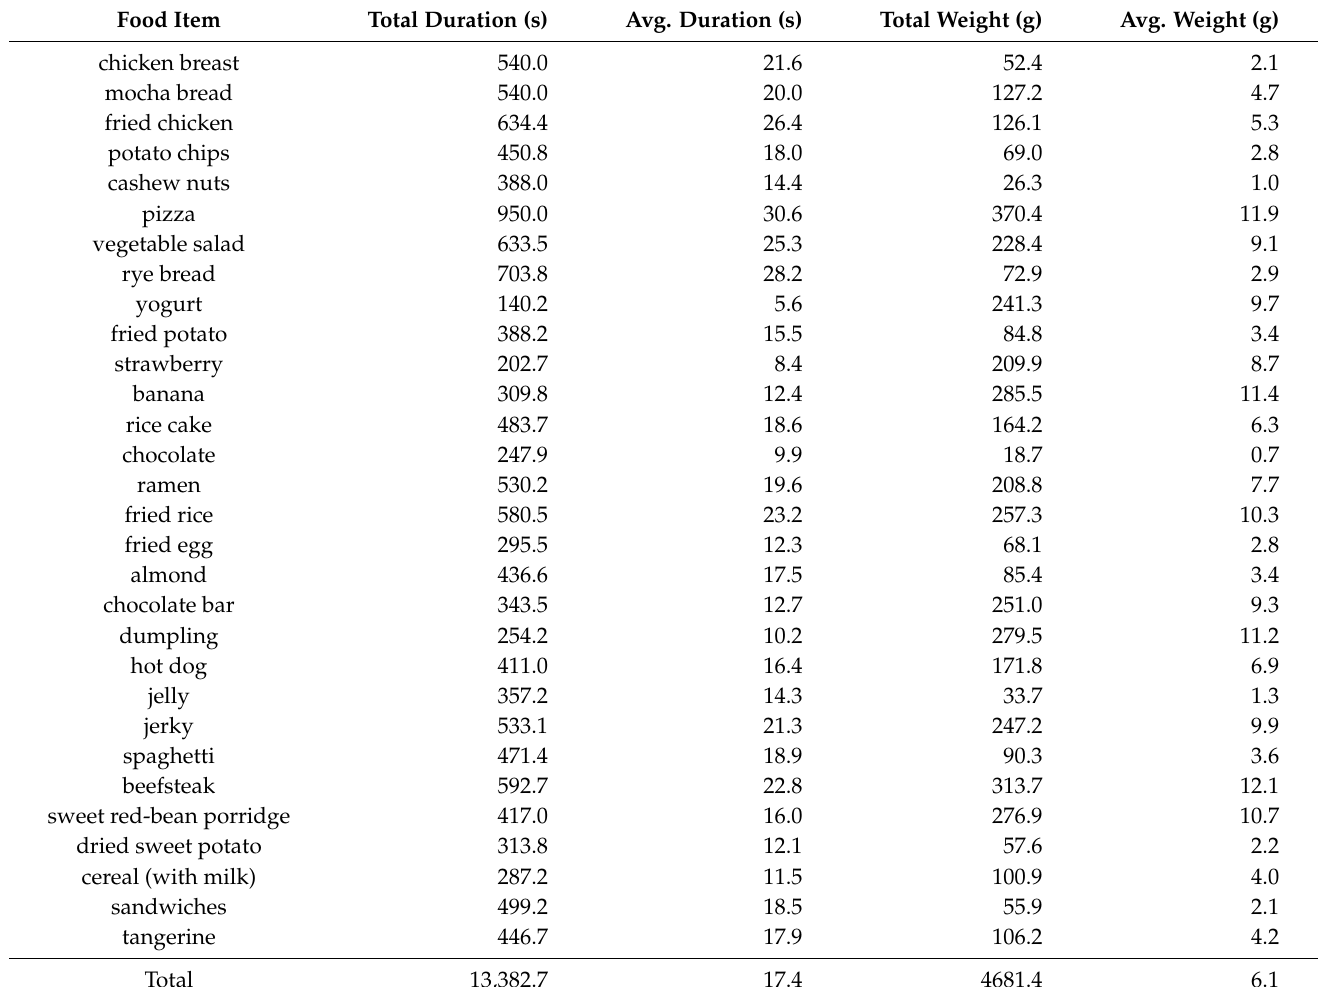
Table 2. Dataset properties per food